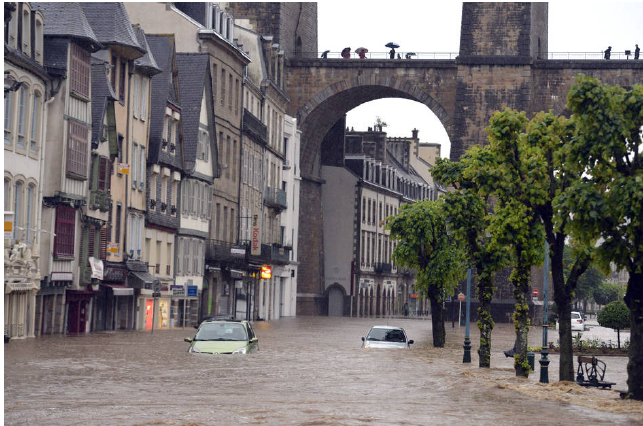
Figure A1. Heavy flooding in the center of Morlaix, France due to a storm on 3 June 2018 (Photo: Le Télégramme).